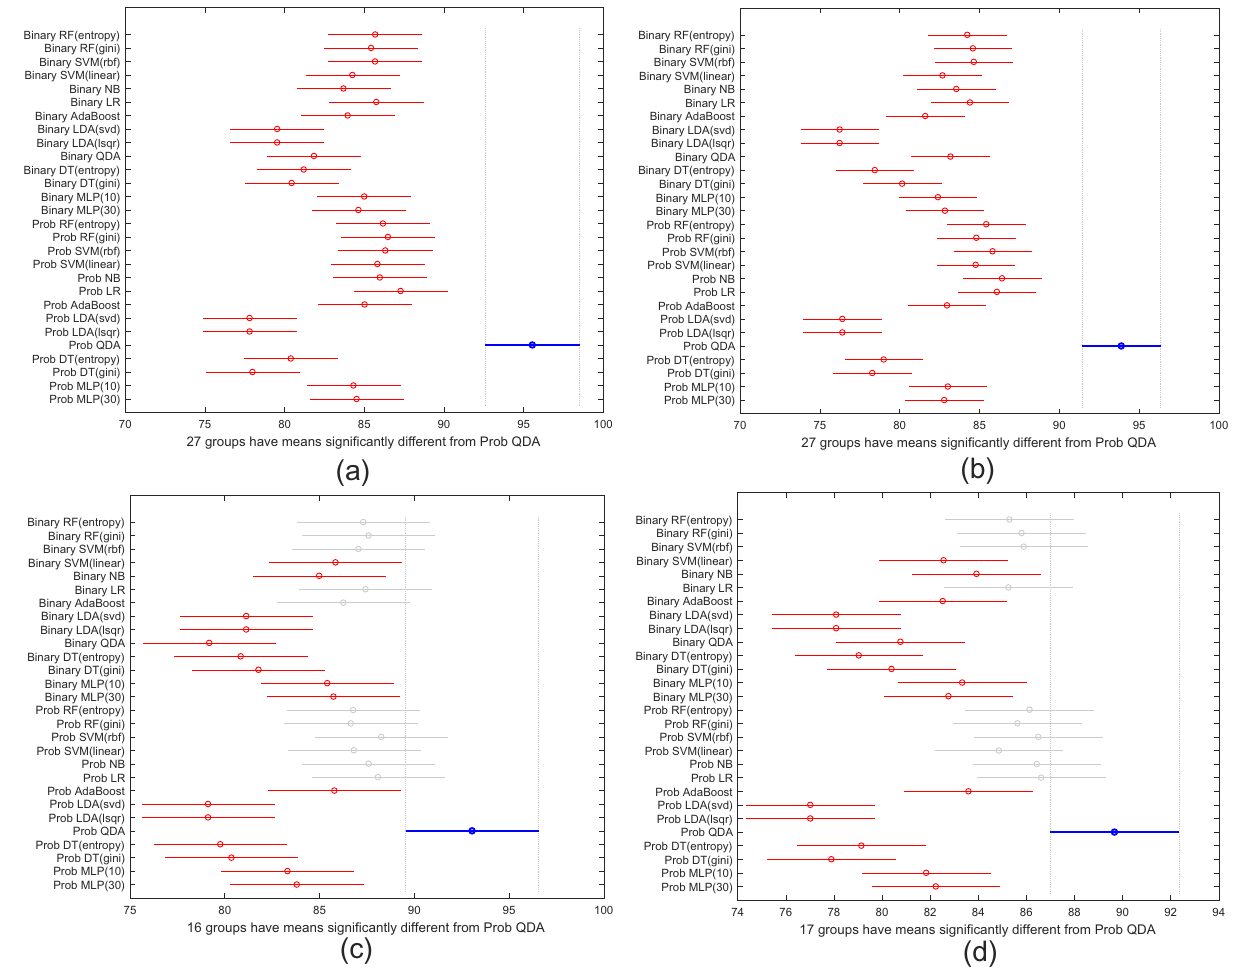
Figure 4. Results of the multiple comparison tests for the classification accuracy of NeurDNet across different scenarios. The term “Prob” in the vertical axis refers to the probabilistic features extracted from the first- stage classifier. The vertical axis represents different testing scenarios and the horizontal one represents the classification accuracy. Also note that the circles denote the mean classification accuracy and the lines define the range of the 95% confidence interval. Please note that in all of the plots, the performance of Prob QDA (in blue) is compared with other scenarios. Any overlap between the lines of two scenarios corroborates that the performance of NeurDNet is not significantly altered by changing one hyper-parameter to another. The plots include significance tests for [portion of test set—patients’ visits accounted]: ( a ) 25% —all visits; ( b ) 35% —all visits; ( c ) 25% —first visits; ( d ) 35% —first consistency of results for the NB classifier with probabilistic features across different training/test ratios, even for the minimum value of 25% for training ( 75% for evaluation), reveals the superior capability of this classifier in grasping the overall distribution of features for the two PD and ET classes. The observed behaviour of the NB classifier in this work is also consistent with its renowned capability in extracting strong classification rules based on minimum amount of training data. To statistically compare the performance of NeurDNet across different scenarios, for each train/test ratio, we have performed a one-way analysis of variance (ANOVA) on the classification accuracy of the 30 random states obtained through different second-stage classifiers and for probabilistic/binary features. In other words, for each train/test ratio, the results of 28 scenarios (14 classifiers 2 set of probabilistic/binary features) are statistically × compared with each other through the ANOVA test. It is worth noting that prior to applying the ANOVA test, the normality of the obtained accuracies for each scenario is verified through Lilliefors test of normality 59 with the confidence level of 5% . Afterward, the results are interpreted based on 95% confidence criteria by multiple comparison plots, as shown in Fig. 4. It is worth highlighting that in the comparisons plotted in Fig. 4, the circle denotes the average of classification accuracies in each scenario, and the lines denote the range for which the confidence interval is defined. In other words, if two cases have overlapping lines, it is understood that the classification accuracies for the two cases are not statistically ( 95% confidence) different. The opposite of this statement also holds for non-overlapping lines, which indicates statistically different accuracies for two sce- narios. It is worth highlighting that in the multiple comparison plots shown in Fig. 4, the vertical axis denotes